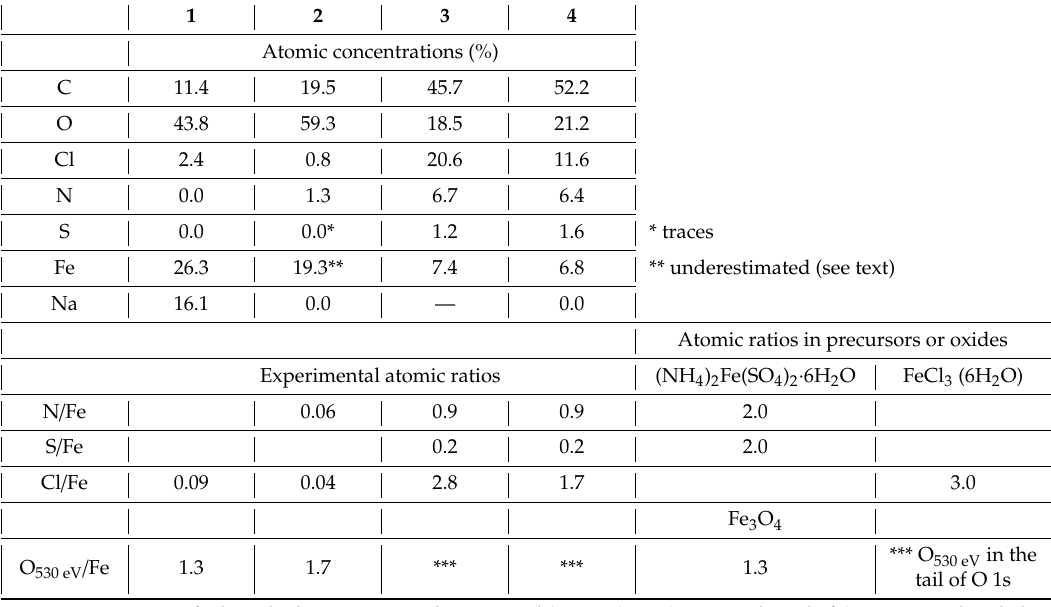
Table 1. XPS quantifications of 1 – 4